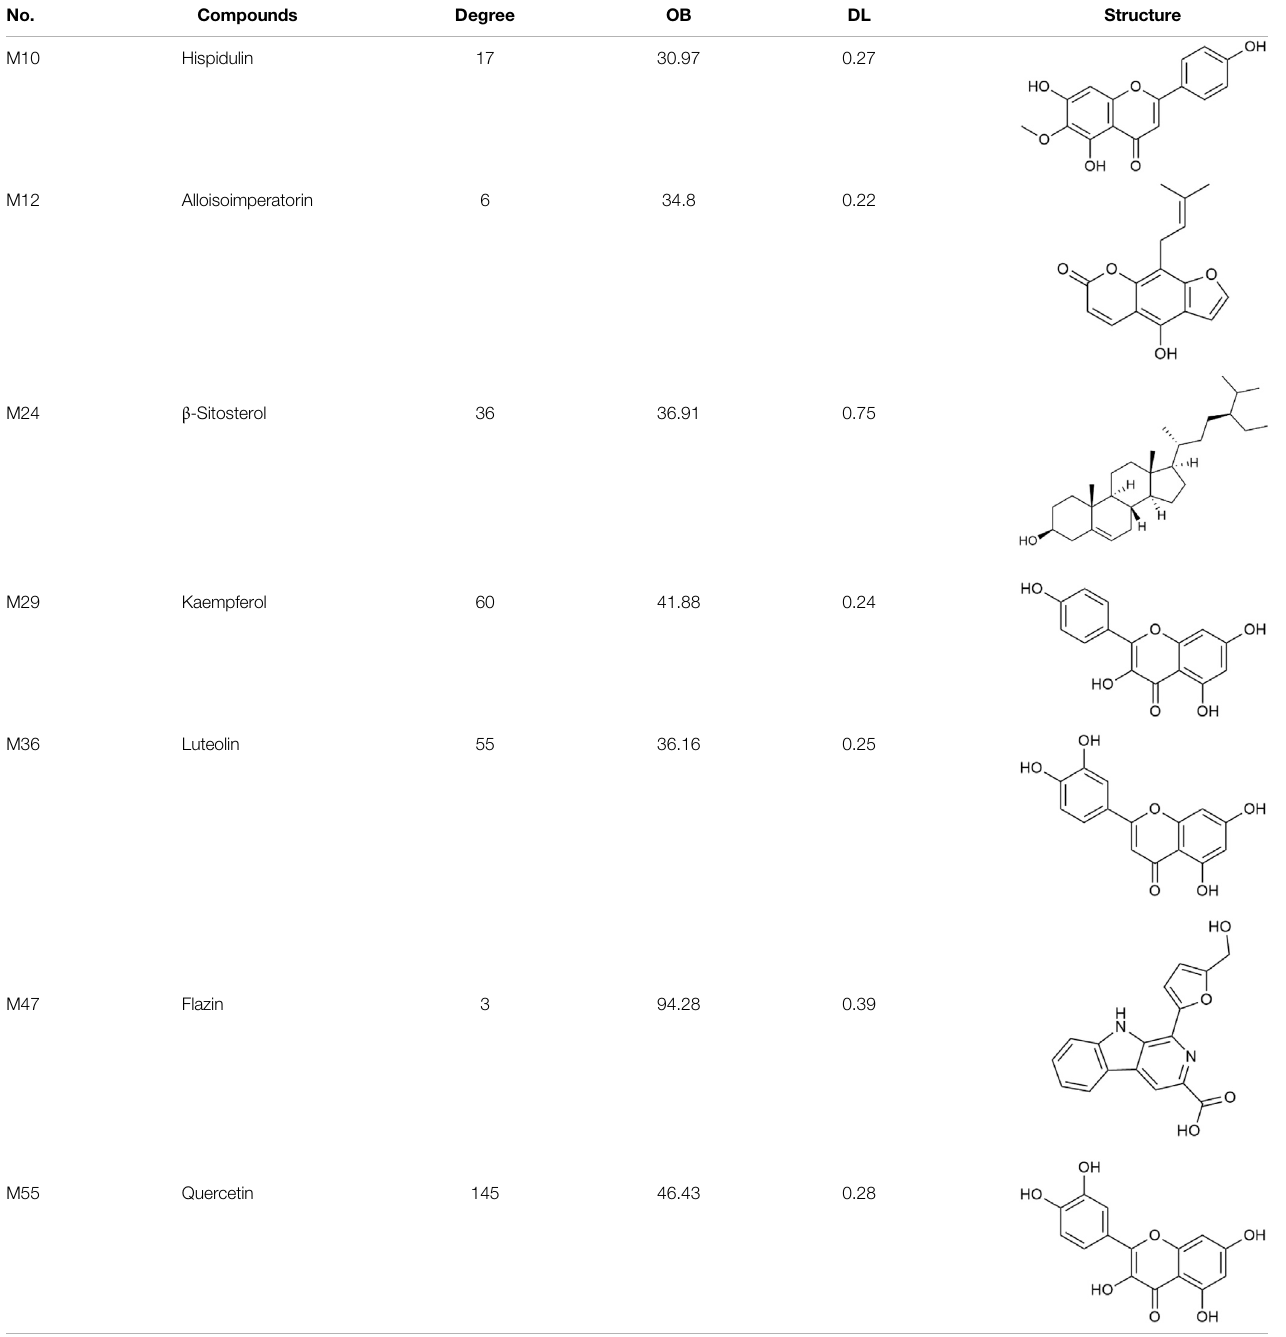
TABLE 1 | Information on candidate compounds in Saussurea involucrata.